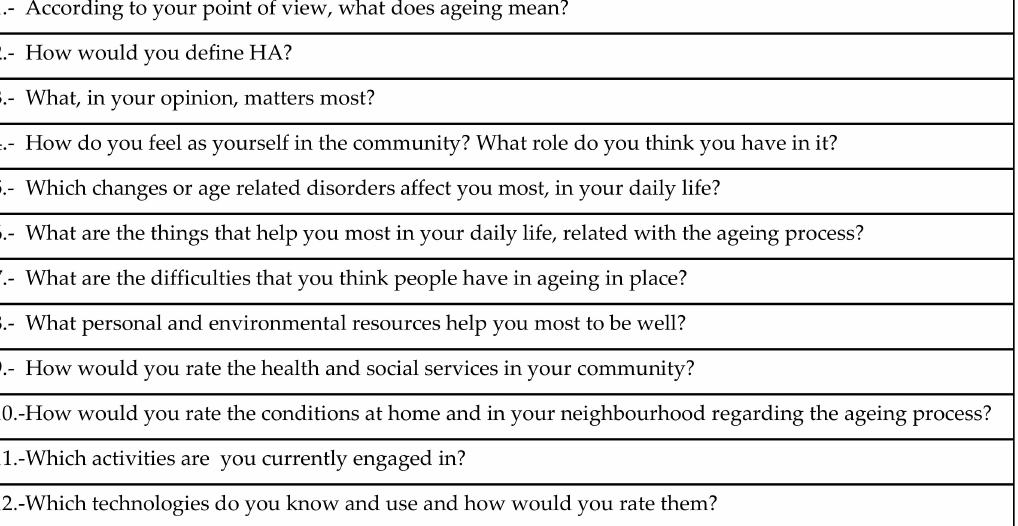
Figure 1. Semi-structured guide used in the focus